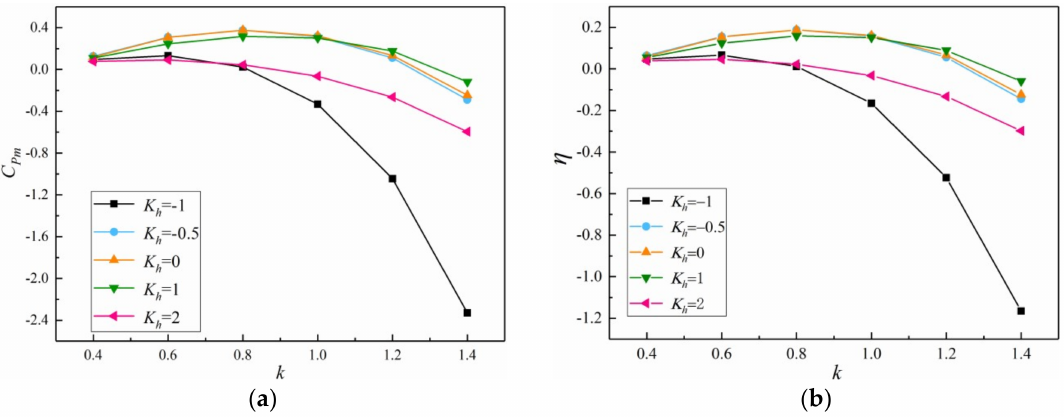
Figure 6. The C Pm and η of parallel foils at different K h : ( a ) C Pm curves under different k ; ( b ) η curves under different k